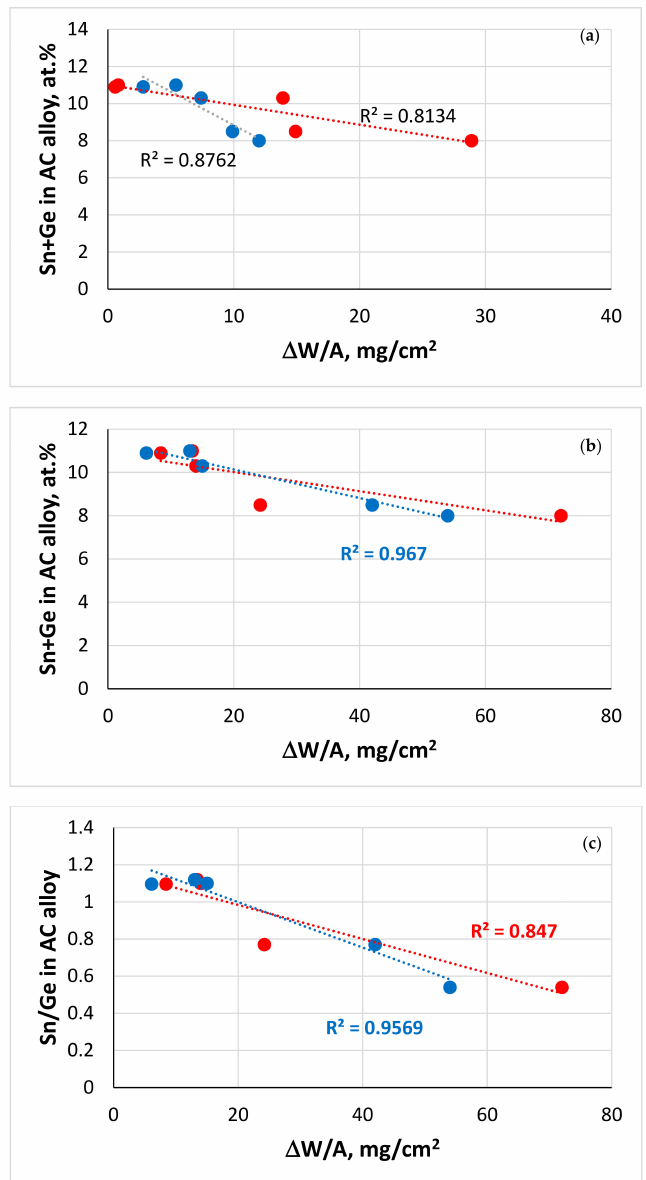
Figure 16. Weight change ∆ W / A versus ( a , b ) Sn + Ge and ( c ) Sn / Ge in as-cast alloys JZ2 [46], JZ3, JZ3 + [47], JZ4 and JZ5 at ( a ) 800 ◦ C and ( b , c ) 1200 ◦ C. Experimental data shown with red colour, calculated data by NICE [20] shown with blue colour. AC = as